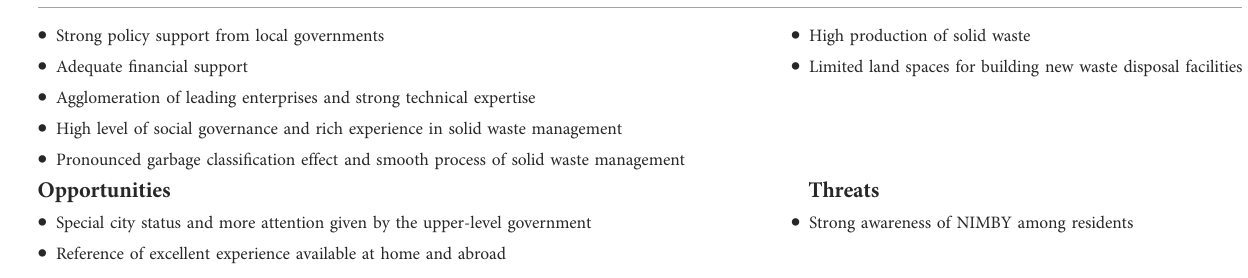
TABLE 1 SWOT analysis of solid waste management in central cities.